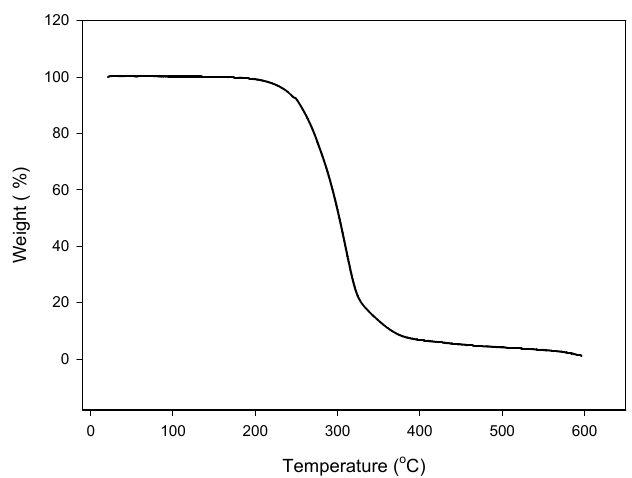
Figure 2. TheThermogravemetric analysis (TGA) curve of acid dimer 1 recorded under nitrogen, with a heating rate of 10 °C/min.